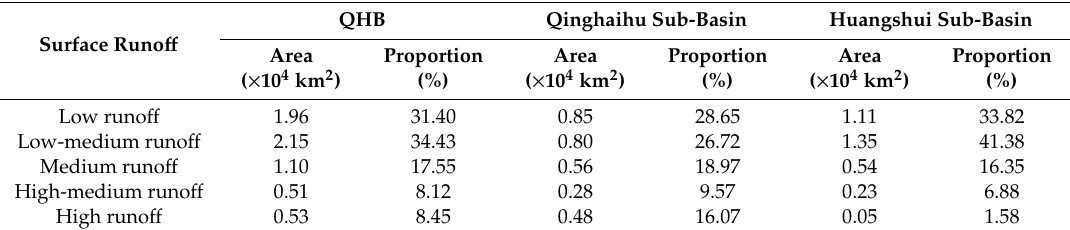
Figure 3. The surface runo ff in 2000. Table 3. The surface runo ff in